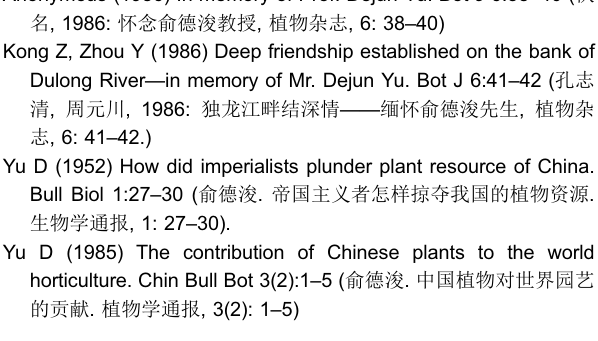
Figure 1. is reproduced by permission of Institute of Botany, the Chinese Academy of Sciences. Figure 2. is kindly provided by Miss. Ruilan Huang, SCBG,